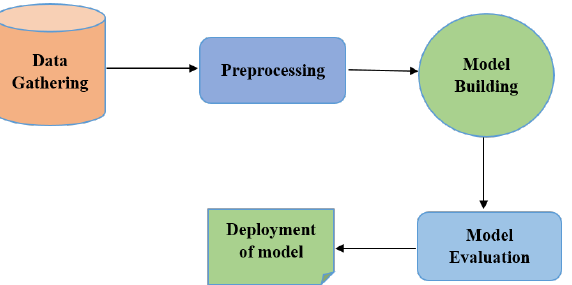
Figure 2. Phases of Text Classification.